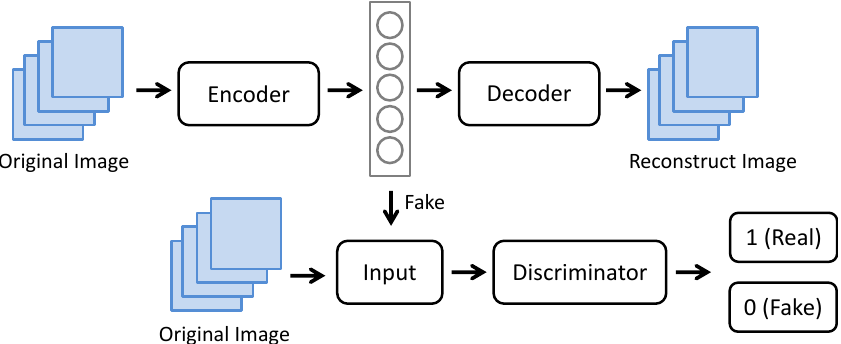
Figure 3. The architecture of the autoencoder model.